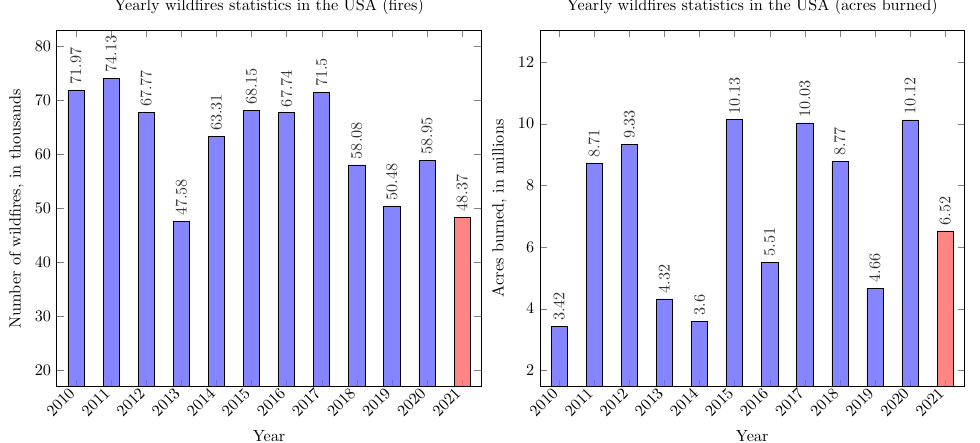
Figure 1. The number of wildfires ( left ) and acres burned ( right ) in the USA from 2010 to 2021. The information is collected from the interagency Fire and Aviation Management Web Applications (FAMWEB) system. The data for 2021 are from the period January 1 to 29 October 2021 (marked in red). Data for the last two months of the year 2021 are not available yet.